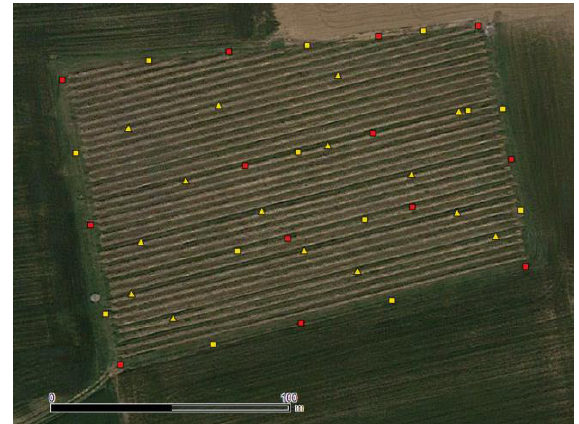
Figure 2. Distribution of points used for the generation of DTM by interpolation and for the photogrammetric